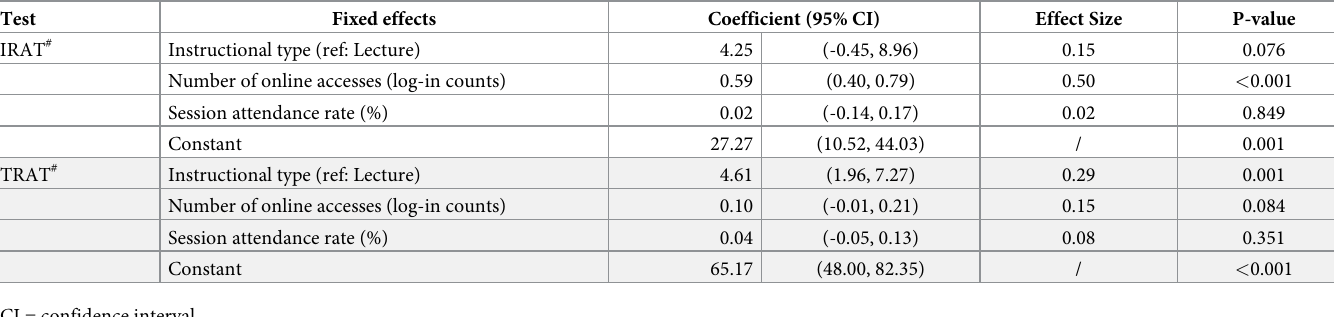
Table 2. Multilevel linear regression